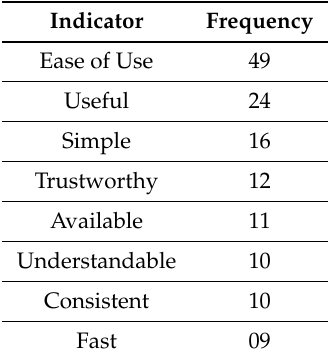
Table 3. Most frequent indicators mapped by the literature